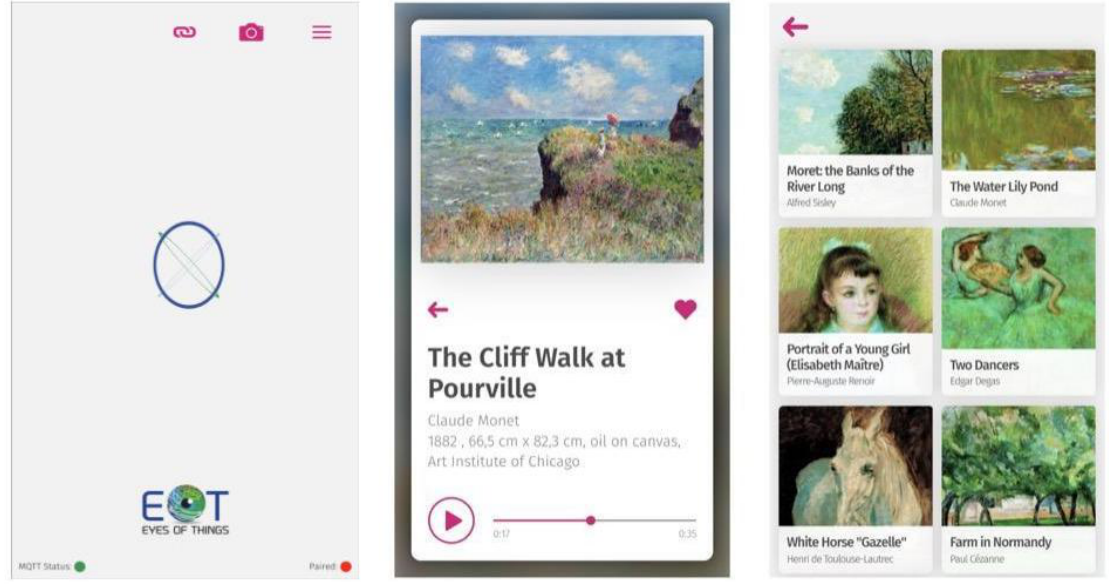
Figure 9. Views of the companion application after